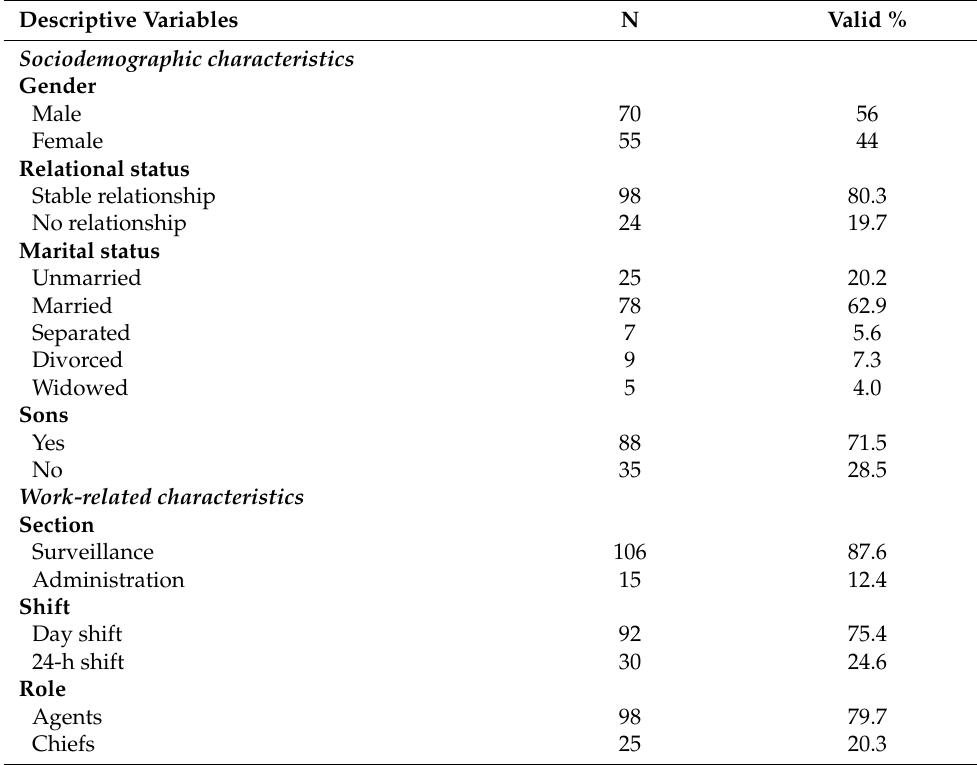
Table 1. Sociodemographic and work-related characteristics of the